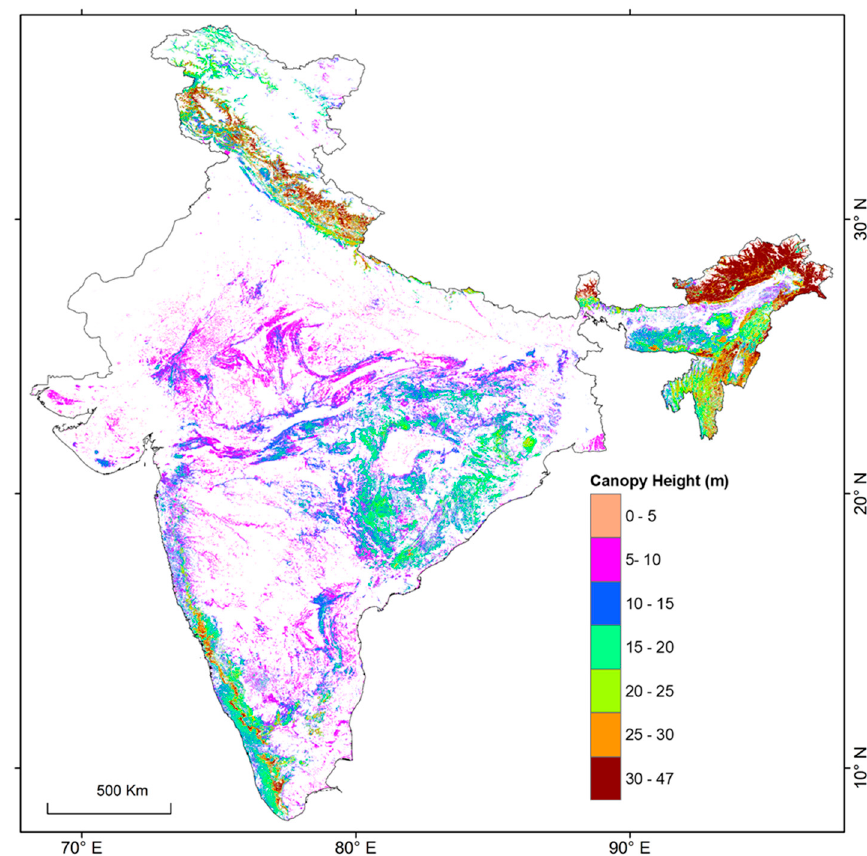
Figure 9. Unified canopy height map of India’s forest cover (excluding grassland).